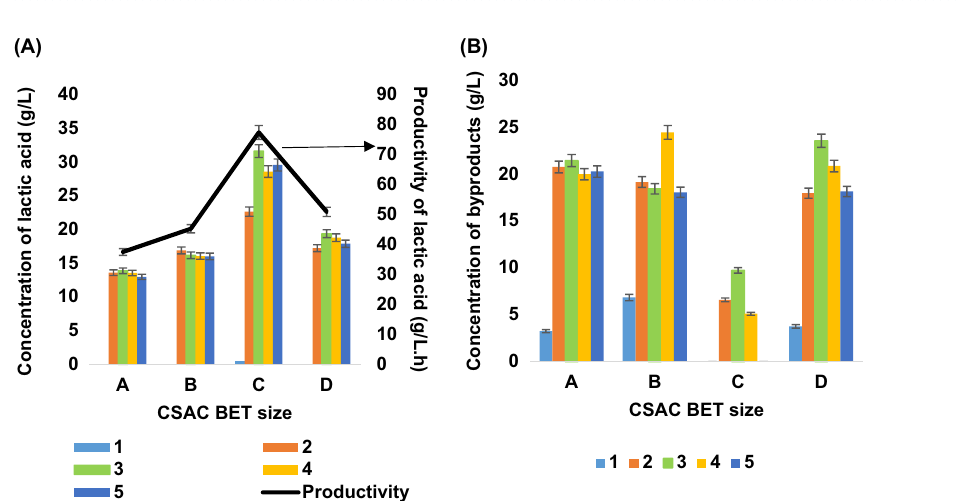
Figure 10. FESEM image of ( A ) cells immobilized on CSAC at × 10.00 k magnification ( B ) (CSAC) at × 10.00 k magnification.